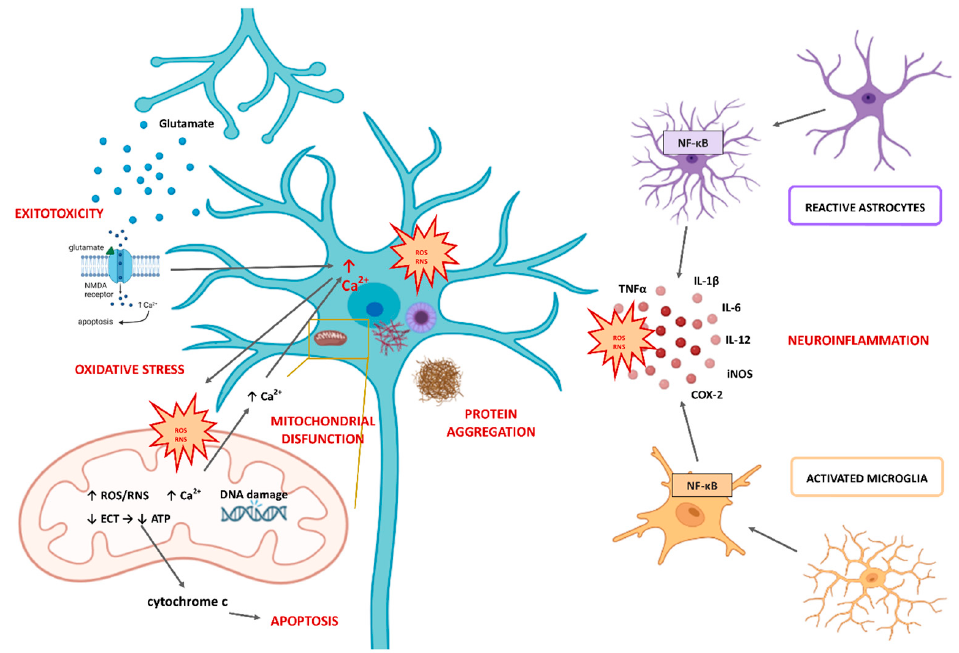
Figure 2. Molecular and cellular mechanisms underlying oxidative stress-stimulated neurodegeneration. Abbreviations: ROS, reactive oxygen species; RNS, reactive nitrogen species; NMDA, N-methyl-D-aspartate receptor; ETC, electron transport chain; NF- κ B, nuclear factor- κ B; IL-, interleukin-; TNF α , tumor necrosis factor alpha; iNOS, inducible form of nitric oxide; COX-2, cyclooxygen- ase-2.